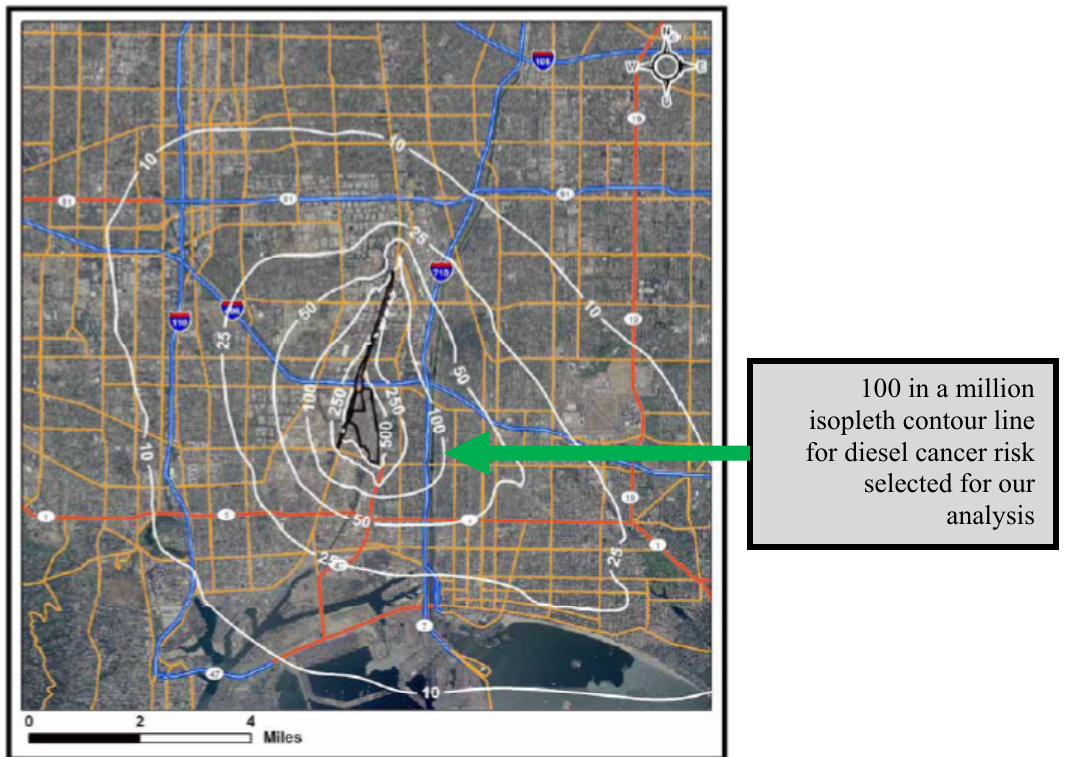
Figure 1. Estimated potential cancer risks (chances per million) associated with diesel particulate matter emissions at the Union Pacific Intermodal Container Transfer Facility (UP ICTF) in Wilmington, CA *.